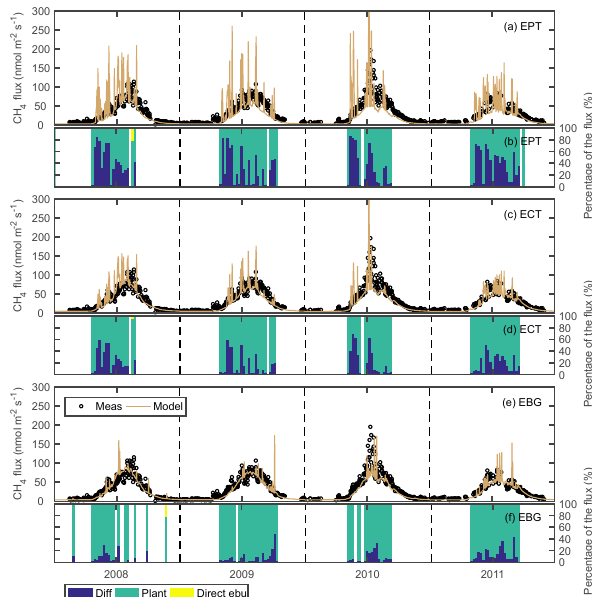
Figure 5. Daily CH 4 fluxes from the fen to the atmosphere obtained using different approaches for modelling ebullition ( a , c and e ) and weekly contribution of three emission pathways to flux ( b , d and f ). The legend for panels ( b ), ( d ) and ( f ) is located at the bottom of the figure. Measured fluxes are shown with circles; diff: diffusion; plant: plant transport; direct ebu: ebullition directly to the surface. The diffusion flux contains the ebullition flux released to the lowest air layer, which is usually below the peat surface. White areas in panels ( b ), ( d ) and ( f ) correspond to periods when over 99% of the flux was related to the plant-mediated